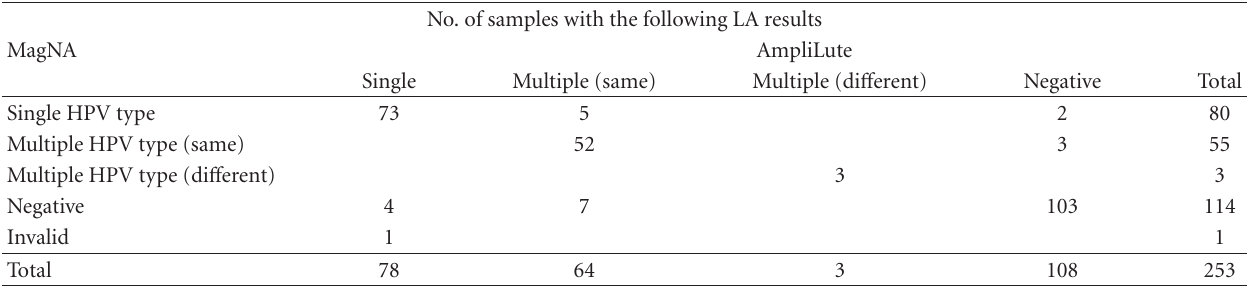
Table 2: Concordance between AmpliLute and MagNA Pure (DNA-I, 1mL) ∗ DNA extracts, in single and multiple HPV infections, identified by LA assay.